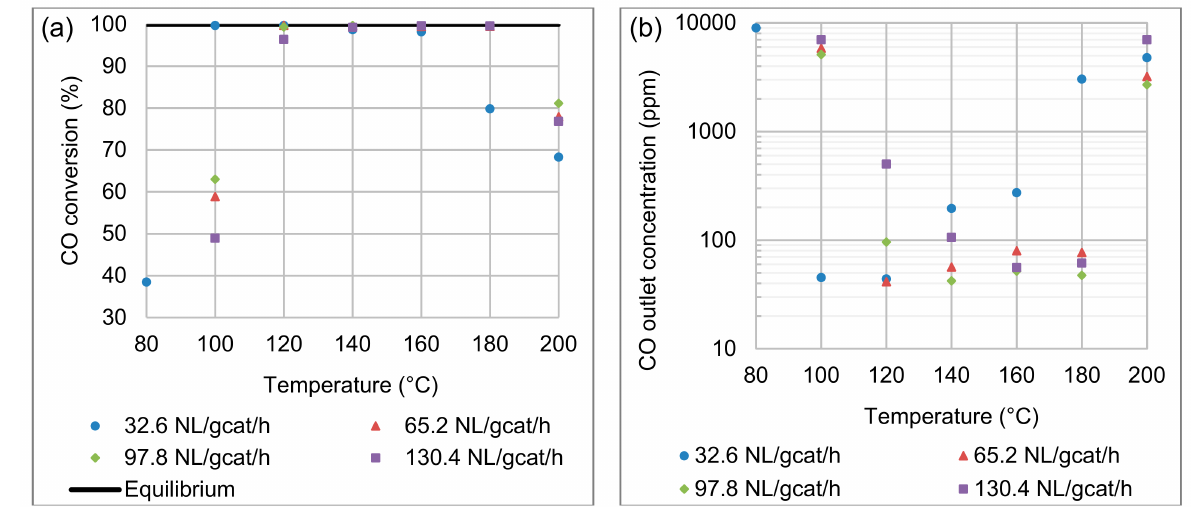
Figure 4. Effects of reaction temperature and space velocity on ( a ) CO conversion and ( b ) CO product concentration. Feed composition: 68.6 vol.% H 2 , 1.4 vol.% CO, 10 vol.% CO 2 , 2 vol.% O 2, and 18 vol.% N 2